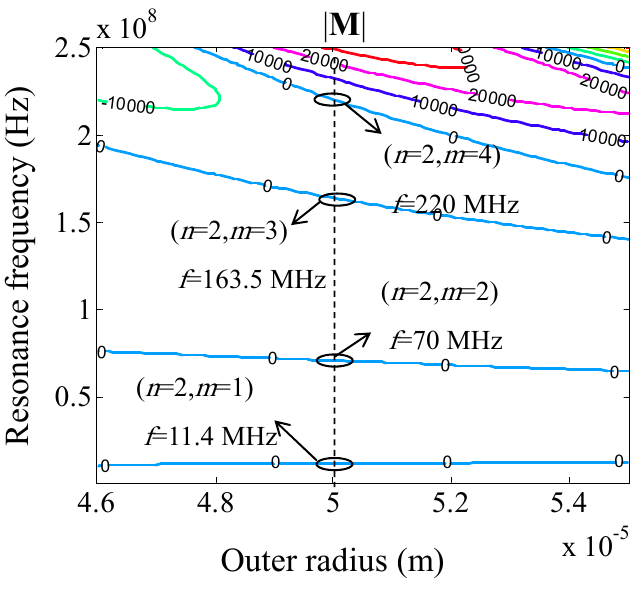
= 30.16 µm and t = 2 µm. i